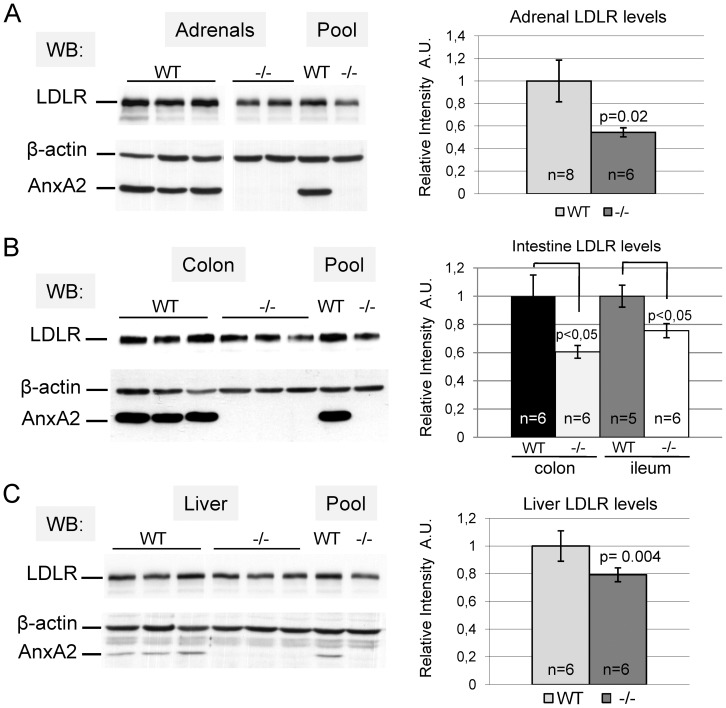
LDLR level is decreased in extrahepatic tissues of AnxA2
−/− mice.(A–C) Western blots of LDLR and AnxA2 in individual tissue samples or tissue pools for adrenals (A), ileum, colon (B) and liver (C) of WT and AnxA2
−/− mice. Scanning densitometry quantification of WB signals obtained for LDLR is shown on the right panels in A–C. LDLR relative intensity was normalized over the signal obtained for β-actin. For each genotype, the number of animals used for quantification is indicated (n = 5–8 per group). Bars and error bars represent average ± SD. P-values were obtained using a two-tailed Student's t-test.